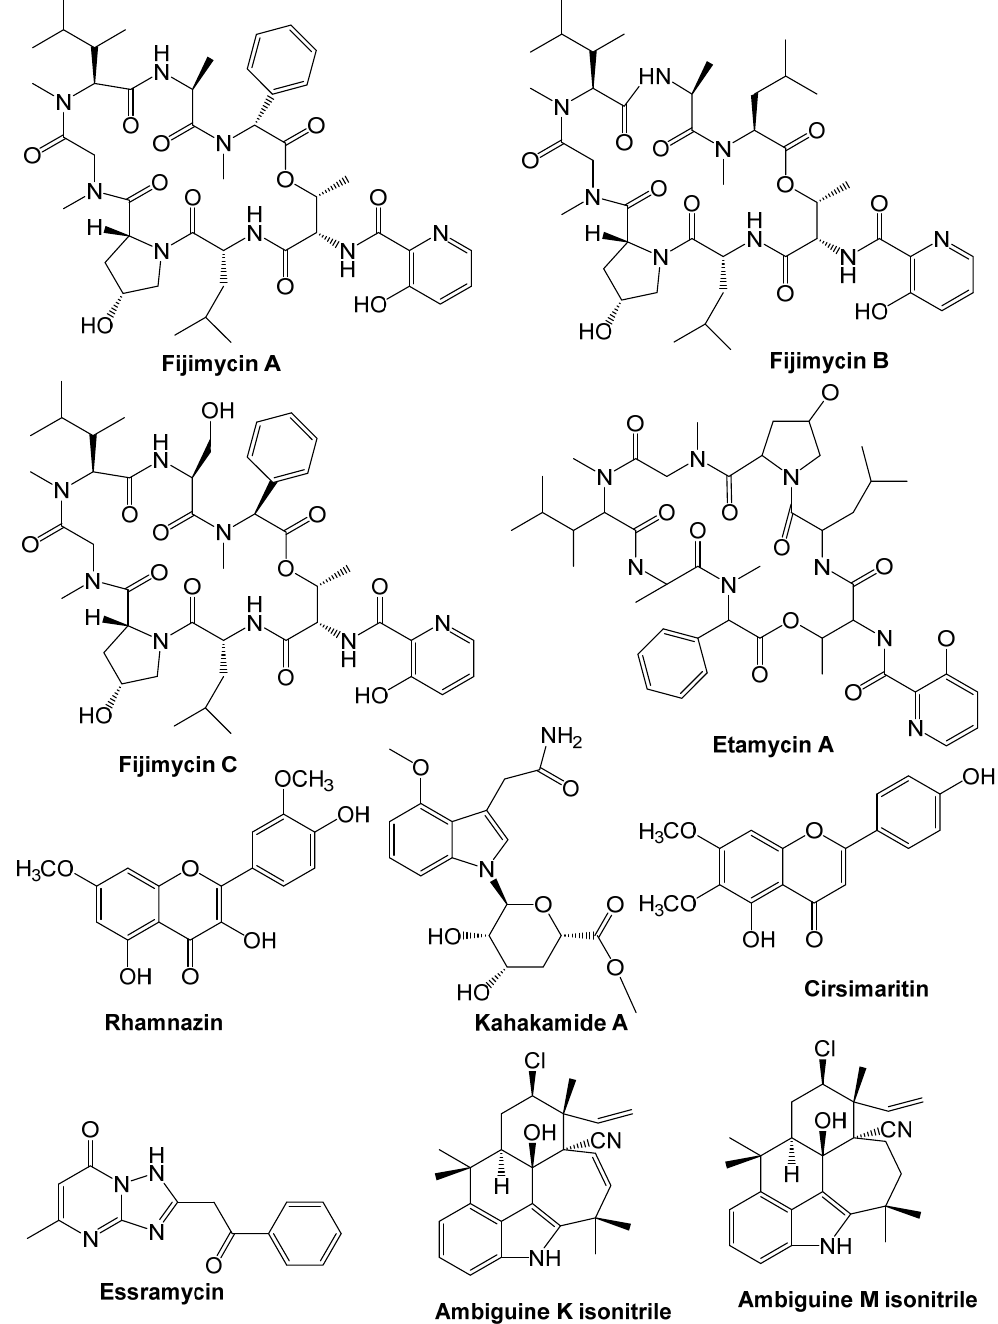
Figure 5. Secondary metabolites presented significant antimicrobial properties from actinobacteria and Cyanobacteria.